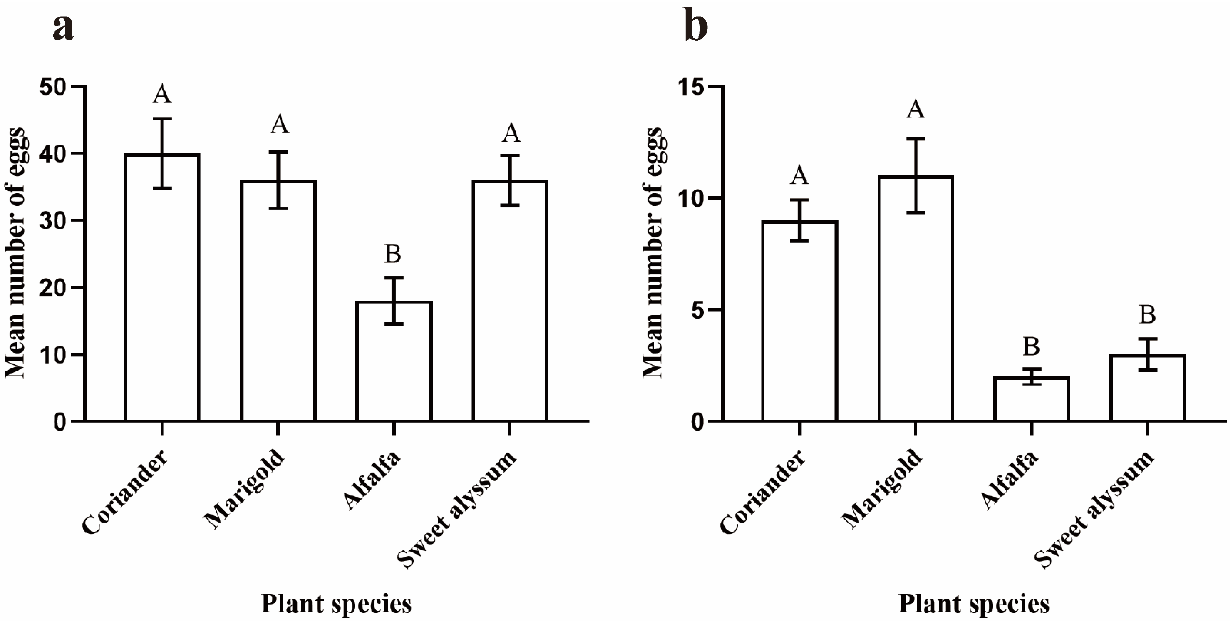
Figure 2. Comparison of the number of Orius sauteri eggs laid among different plant species. ( a ) Single-choice assay ( n = 12; α = 0.05; ANOVA); ( b ) multiple-choice assay ( n = 11; α = 0.05; Kruskal–Wallis nonparametric comparison). Values are mean ± SE (mean: Egg amount of five females in 48 h). Means indicated by the same letter are not significantly different according to LSD test.